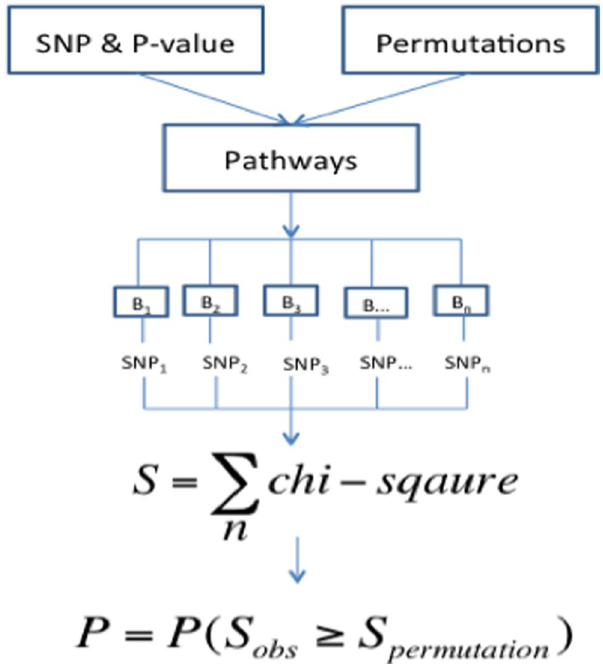
Figure 1. The workflow of DGAT-path to assess pathway